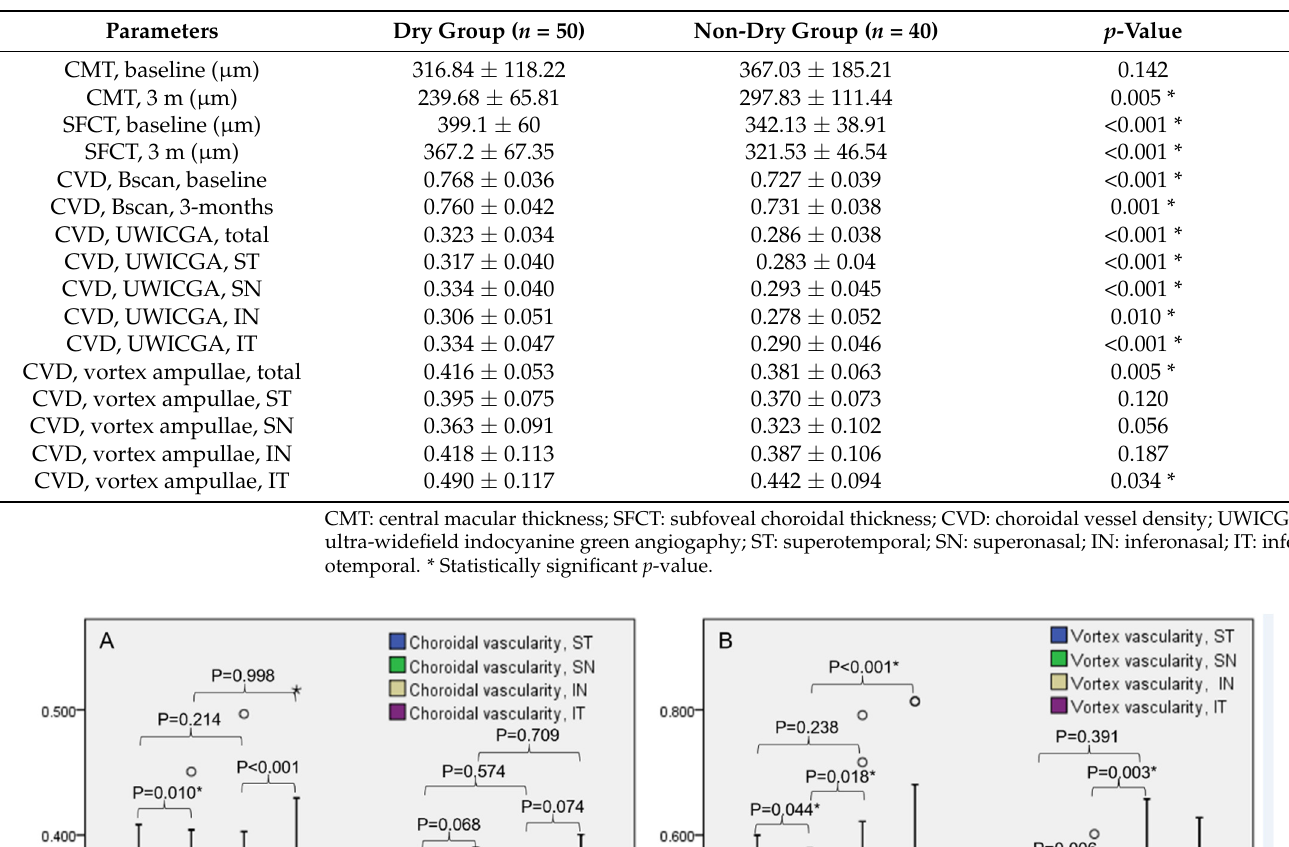
Table 2. Comparison of quantitative choroidal features between dry and non-dry pachychoroid neovasculopathy groups.